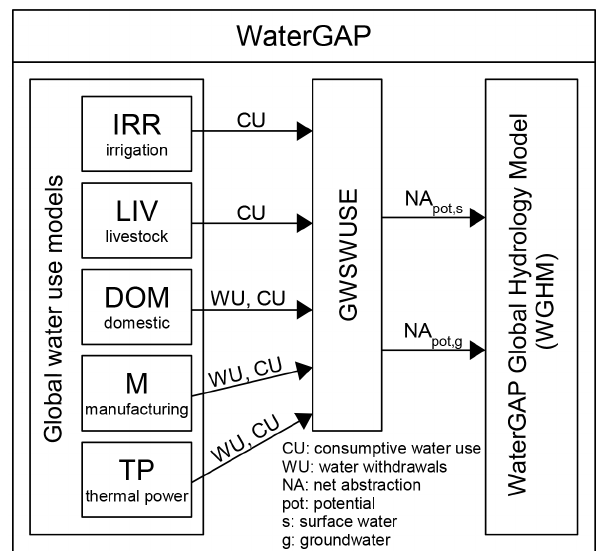
Figure 1. The WaterGAP 2.2d framework with its water use mod- els and the linking module GWSWUSE that provides potential net water abstraction from groundwater and surface water as input to the WaterGAP Global Hydrology Model (WGHM). Figure adapted from Müller Schmied et al.